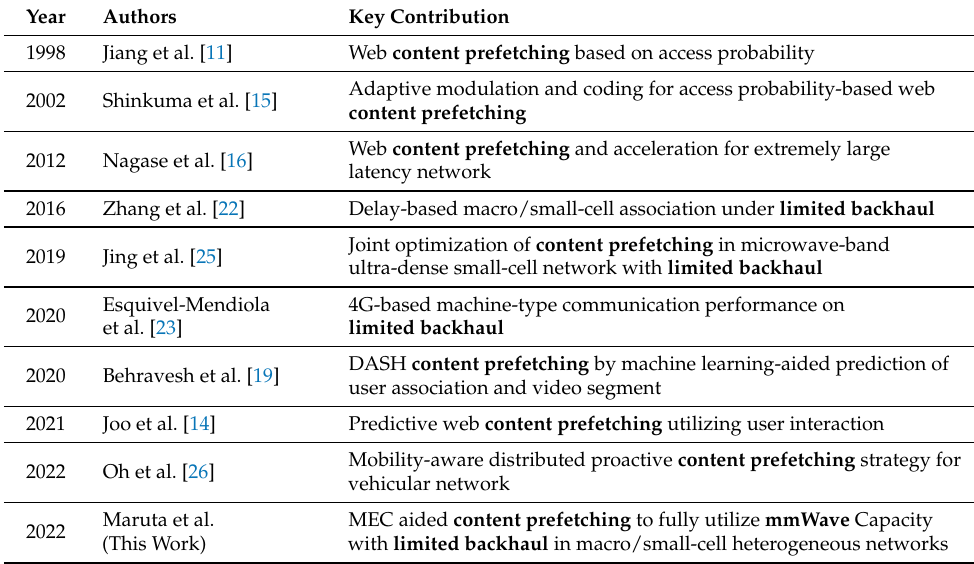
Table 1. Contributions to content prefetching and cellular network under constrained